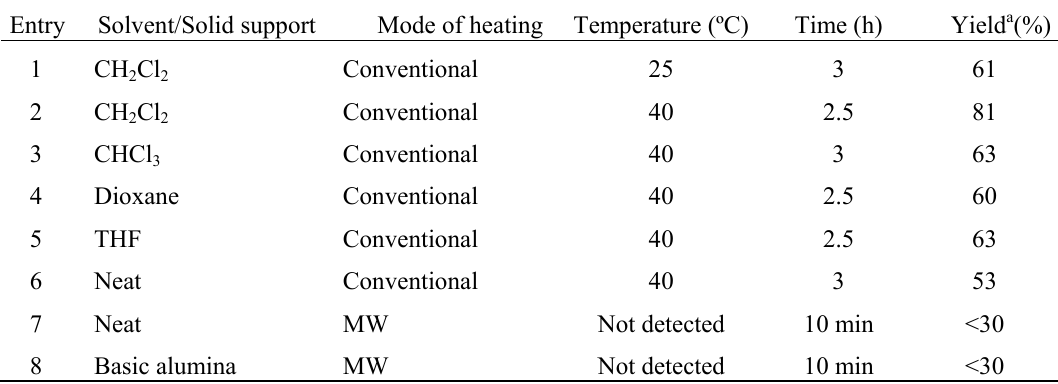
Table 1. Study of the synthesis of 3-benzoylpyrrole 4a under different conditions.